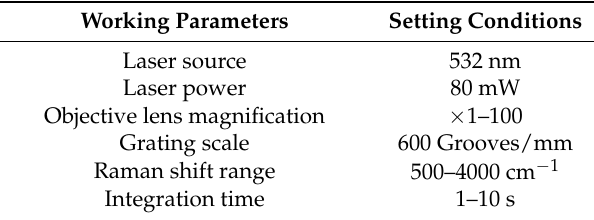
Table 1. Working parameters of the laser Raman